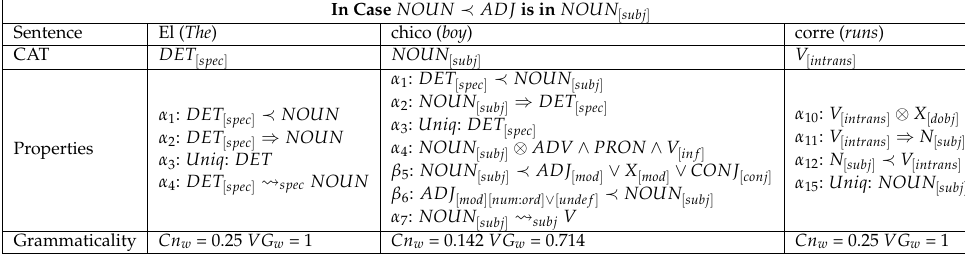
Table 9. Example of including NOUN ≺ ADJ in NOUN [ subj ] .